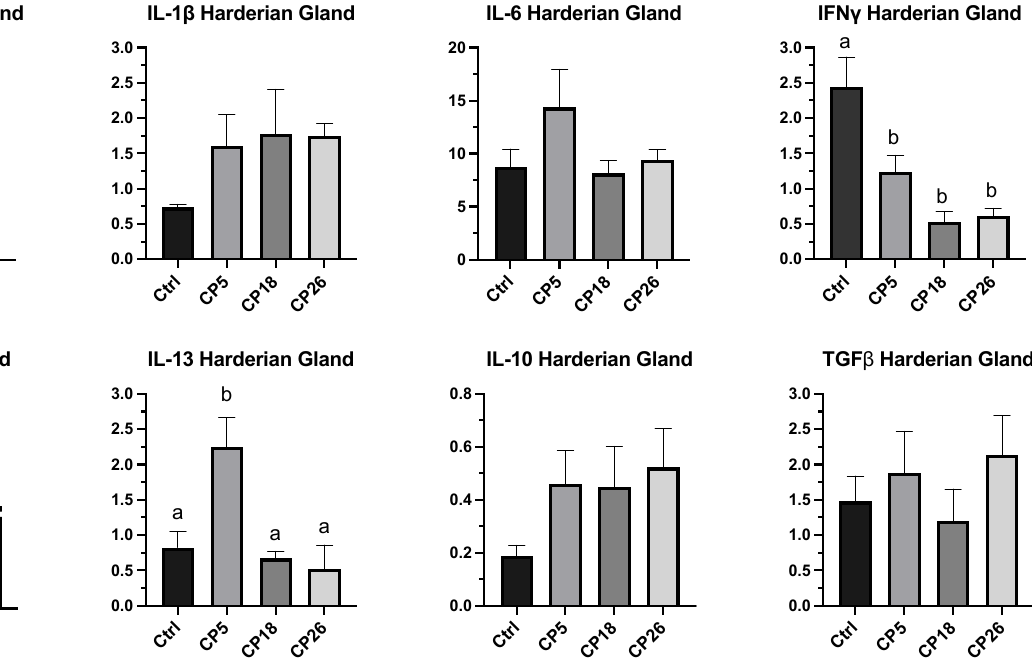
Figure 6. Effect of C. perfringens on immune system gene expression in the Harderian gland of broiler chickens. One-day-old commercial broiler chickens were fed an antibiotic-free diet and challenged with one of three different C. perfringens strains along with the uninfected control via intracloacal inoculation on day 18 of age, administered twice daily for 4 consecutive days, followed by necropsy on day 22. Harderian glands were collected in RNAlater for RNA extraction and cDNA synthesis. Real-time PCR to quantify the expression of IL-1 β , IL-4, IL-6, IL-10, IL-13, IFN γ , TLR-21, and TGF β genes was performed along with the housekeeping gene ( β -actin). The expression levels are shown as relative to β -actin. Different letters above the standard error of mean bars indicate significant difference ( p < 0.05) between the groups. Ctrl—Control (uninfected); CP— C. perfringens strain.